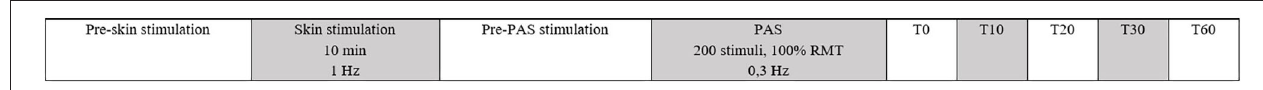
FIGURE 2 | The PAS protocol with skin